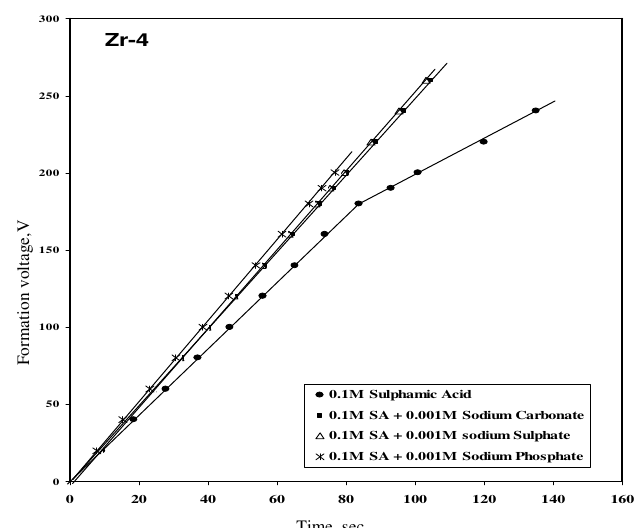
Figure 3 . Plot of formation voltage as a function of time in anion impurity solution